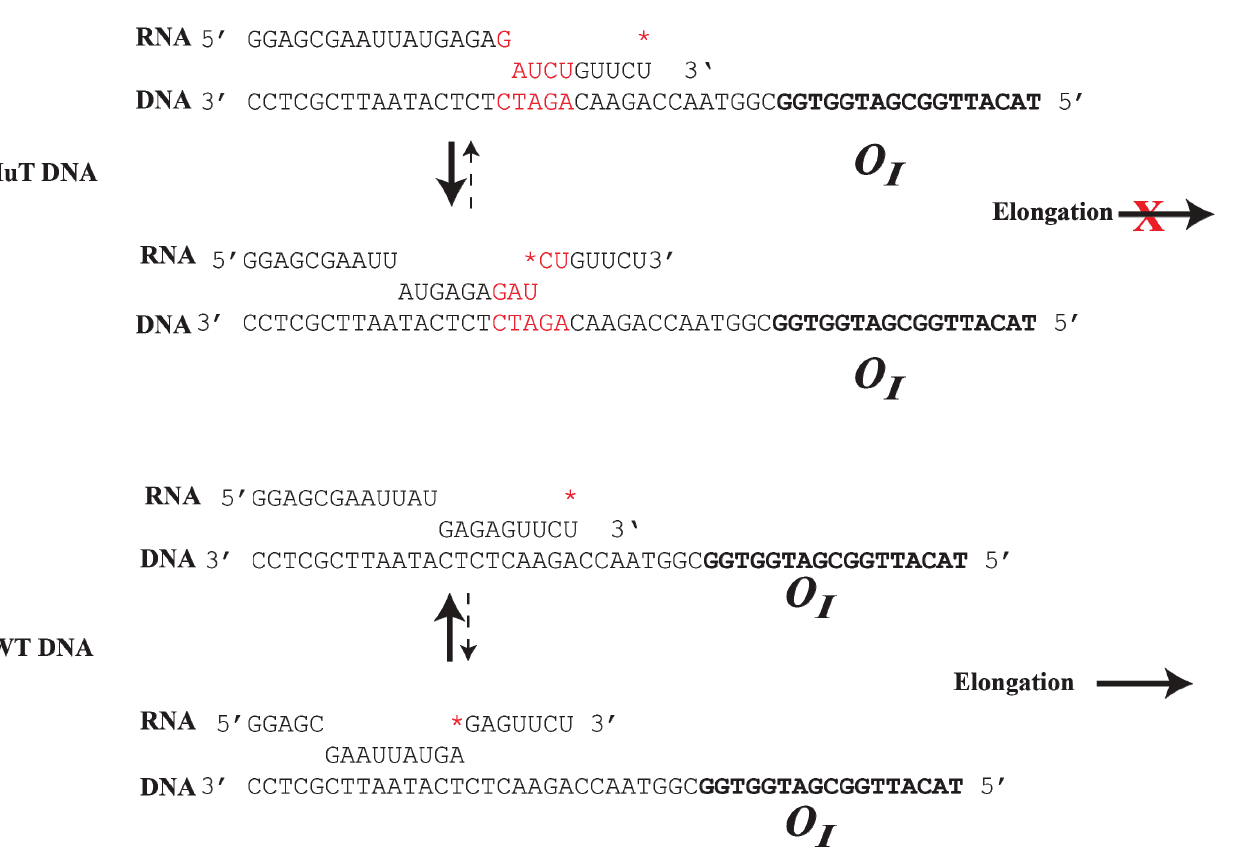
Figure 8. Role of DNA sequence in RNAP elongation or backtracking. ( Top ): The mutant DNA contains an insertion of 5-bp (GATCT, red color), which creates a weak RNA:DNA hybrid at the 3' end of the RNA. RNAP prefers to backtrack to a more stable RNA:DNA hybrid from a weak hydrid, preventing elongation; ( Bottom ): In WTDNA, a strong 9-bp RNA:DNA hybrid is formed at the gal pause site upstream from O I . RNAP prefers to elongate instead of backtracking by 7-bp to a weak RNA:DNA hybrid. The * indicates the 3' end of the RNA (reproduced with permission from Elsevier